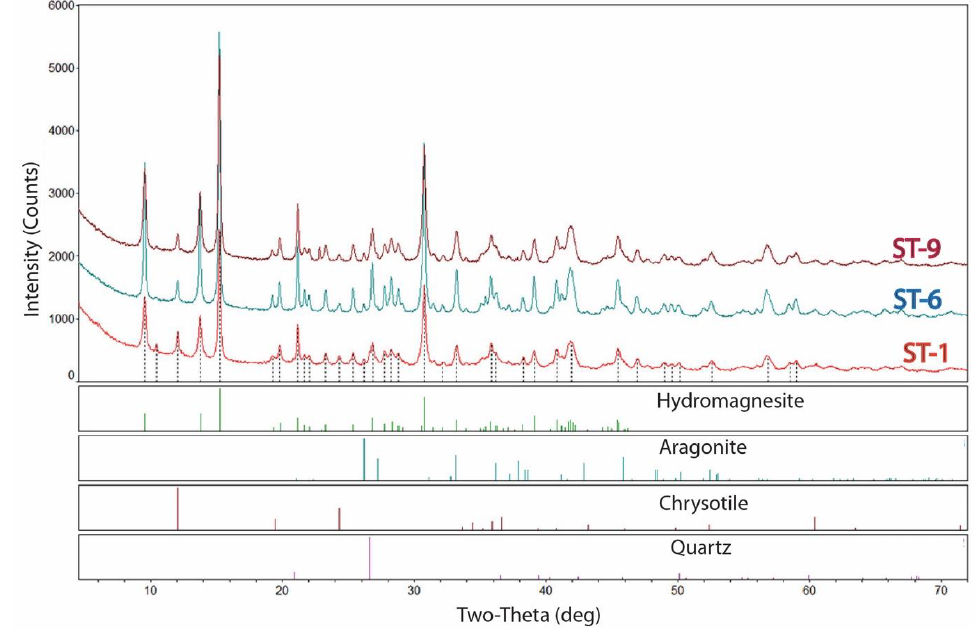
Figure 3. Representative X-ray diffraction pattern of the stromatolite samples in Lake Salda for ST-1, ST-6 and ST-9 samples. Table 2. Major oxide contents of the stromatolites from Lake Salda, in weight percent (wt.%).